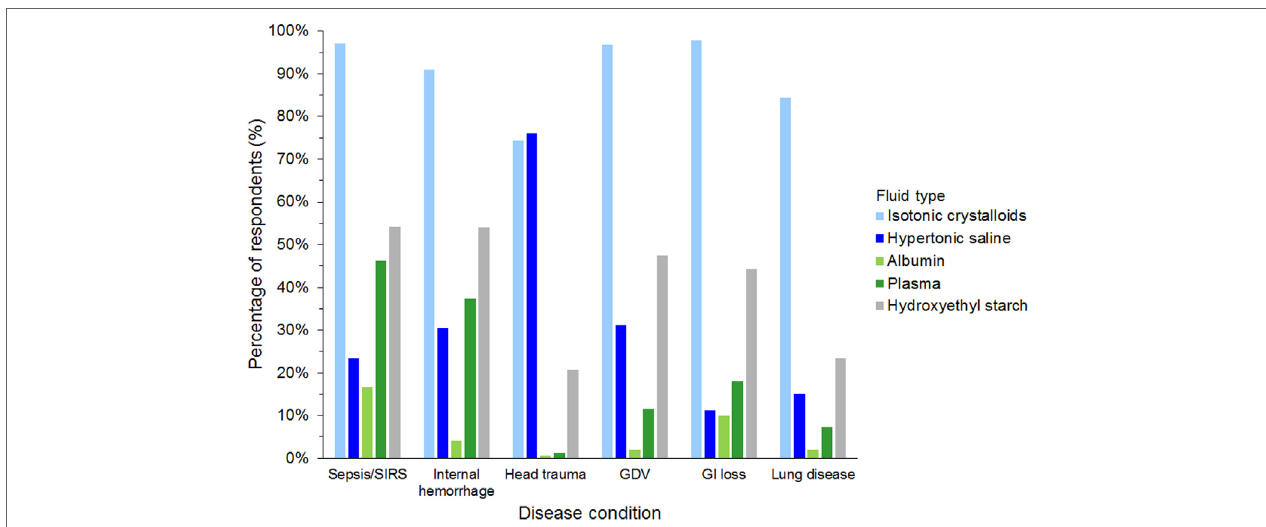
FigUre 4 | Frequency chart showing the type of intravenous solutions used by the 1,134 survey respondents for fluid resuscitation in specific disease conditions. SIRS, systemic inflammatory response syndrome; GDV, gastric dilatation-volvulus; GI loss, gastrointestinal